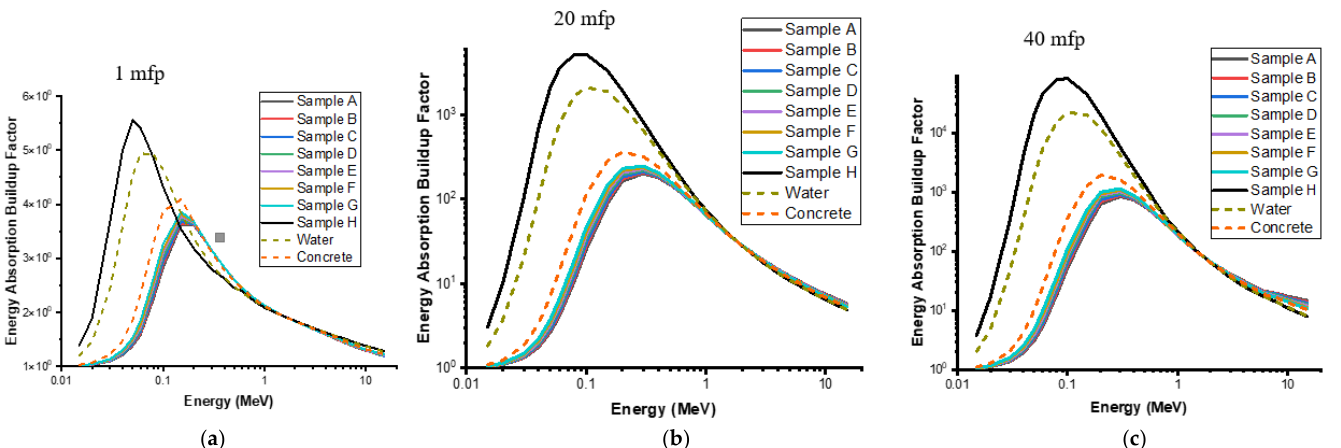
Figure 6. EABF of the Samples compared with water and concrete for energy region 0.015–15 MeV at 1, 20 and 40 mfp, respectively. ( a ) is 1 mfp, ( b ) is 20 mfp and ( c ) is 40 mfp.